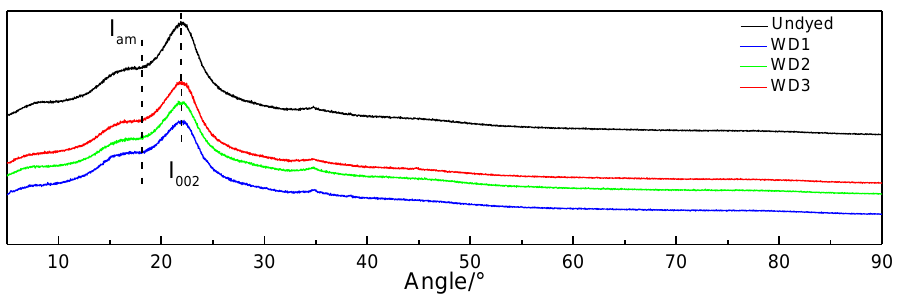
Figure 7. X-ray diffraction images of poplar wood infected for 40 days under different induction factors.